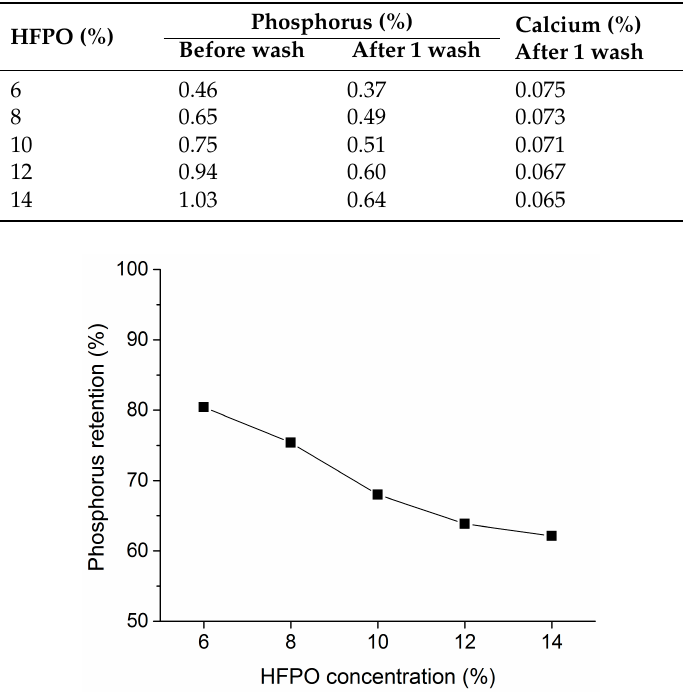
Figure 3. The phosphorus retention of the Nomex ® /cotton fabric treated with 3% BTCA and HFPO with different concentrations, cured at 170 °C for 3 min and finally subjected to one home laundering